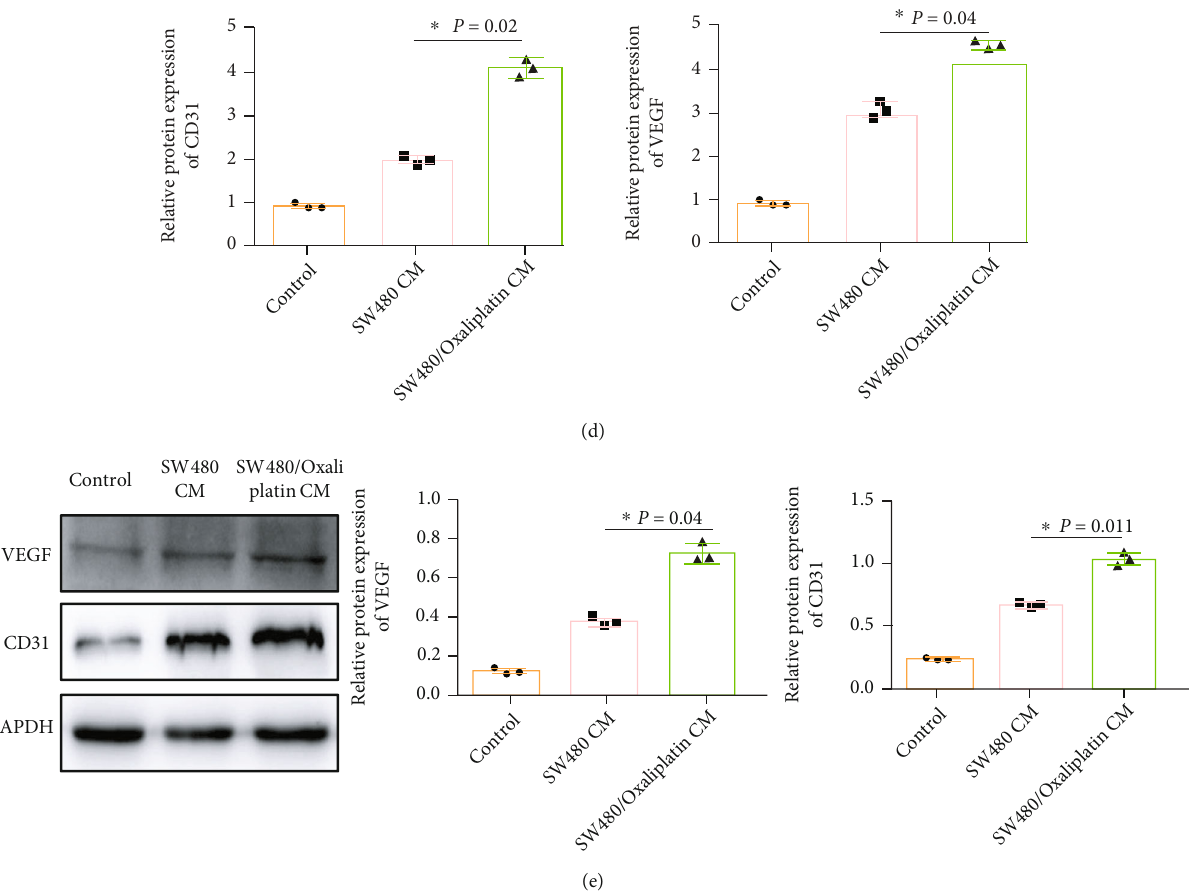
Figure 1: Conditioned medium (CM) extracted from SW480-resistant colon cancer cells enhance angiogenesis. HUVECs treated with CM of SW480/oxaliplatin and SW480 cells. (a) Proliferation assay of HUVECs. (b) The Transwell assay determined the HUVECs migration. (c) Photomicrographs of tube-like structures and quanti fi cation of the tube number. (d) The mRNA level of VEGF and CD31. (e) Then, protein expression of CD31 and VEGF in HUVECs. All above experiments were repeatedly performed 3 times; data are shown as the means ± SD . ∗ P < 0 : 05 , ∗∗ P < 0 : 01